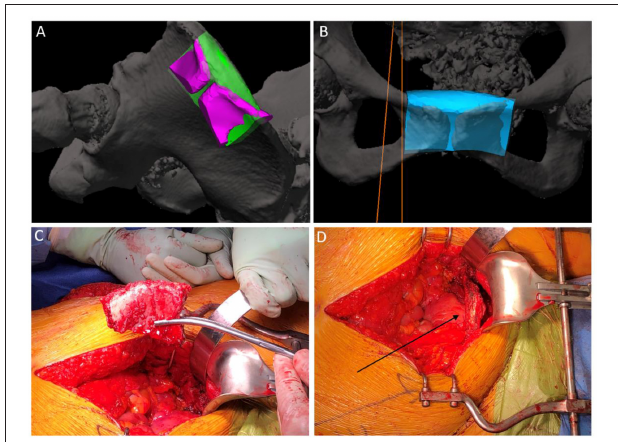
FIGURE 3 | Intra-operative photos. (A) demonstration of the computer-navigated iliac crest resection with pubic cut overlay. (B) demonstration of iliac crest craft positioning. (C) iliac crest graft post resection. (D) Arrow demonstrating positioning of iliac crest graft in the resected pubis.